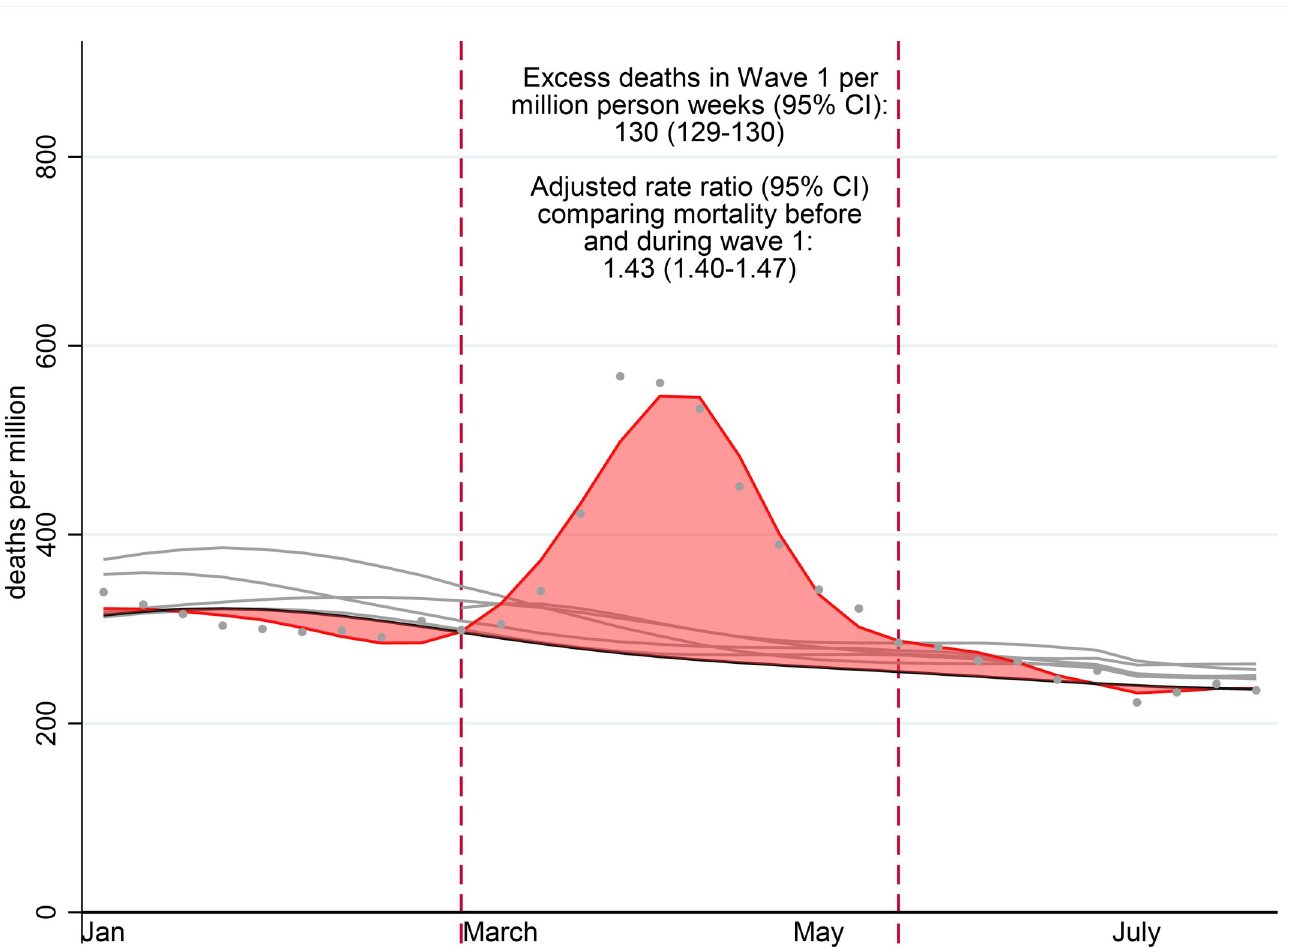
Fig 2. Observed number of deaths from all causes per million person-weeks in 2020 before and during the pandemic and year-specific fitted curves for the years 2015 to 2020. Solid grey lines: model fitted numbers of deaths in 2015–2019 (predicted from year and season model restricted to 2015 to 2019). Grey dots: Observed deaths in 2020. Solid red line: model fitted number of deaths in 2020 using natural cubic spline (with 8 knots per year before the pandemic and an additional 3 knots during the pandemic). Solid black line: predicted number of deaths in 2020 from year and season model fitted on 2015–2019 data. Dotted red lines: start and end of Wave 1. Red shaded area: excess number of deaths during the pandemic. Excess deaths per million patient-weeks = Total number of observed deaths (grey dots) in Wave 1 of the pandemic minus predicted number according to the 2015–2019 model (solid black line) Adjusted rate ratio of Wave 1 versus prepandemic period–Estimated by the model fitted on the full study population adjusted for age, sex, and annual and seasonal effects.